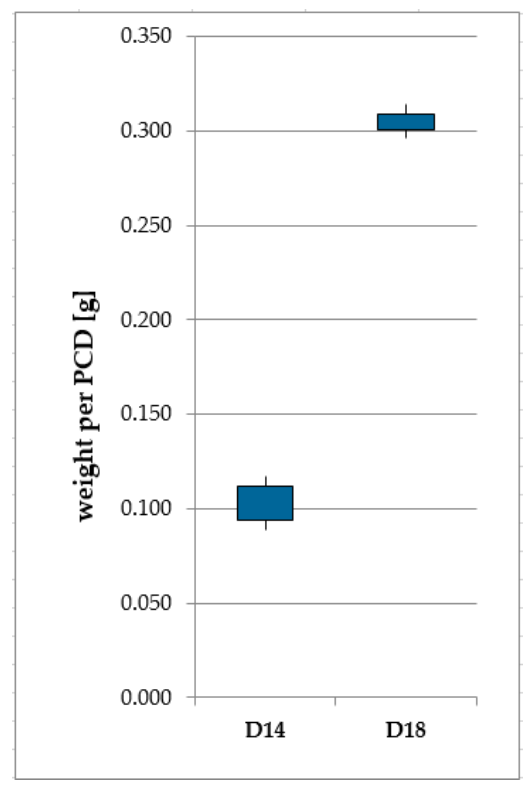
Figure 3. Deviations in weight of individual D14 and D18 PCD blanks.